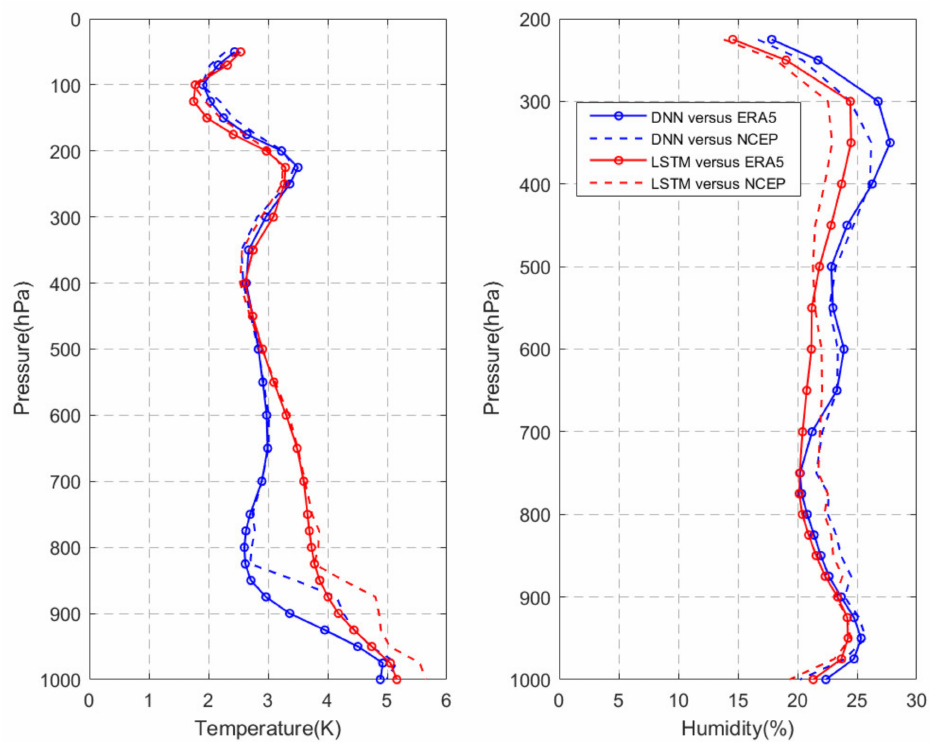
Figure 14. The retrieval RMSEs of the DNN model and the LSTM model with respect to ERA5 and NCEP reanalysis data over mixed surface in February